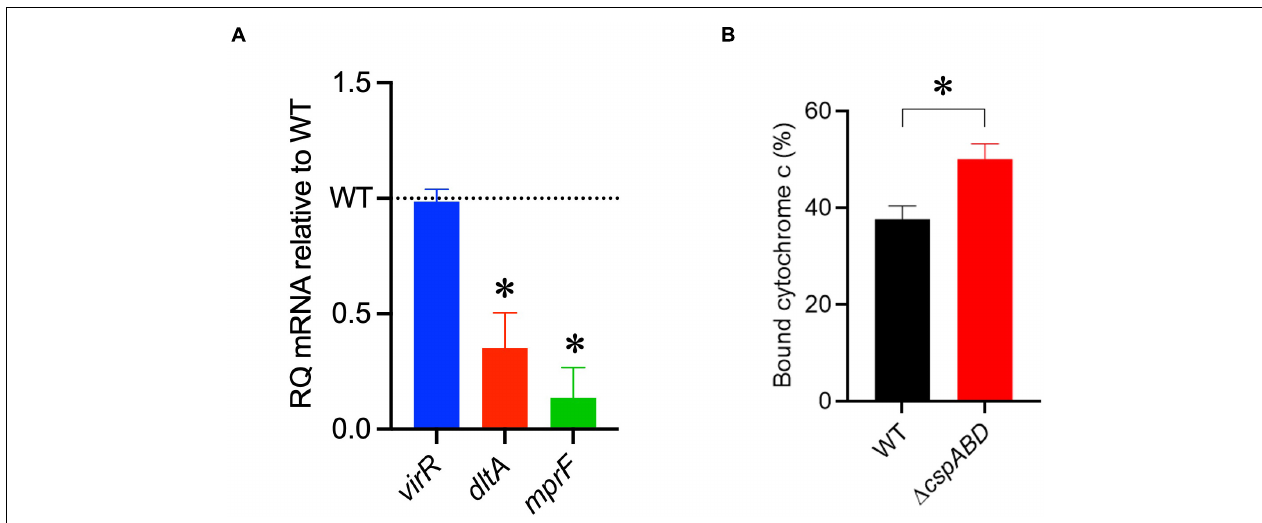
FIGURE 6 | A (cid:49) cspABD mutation reduces the mRNA abundance of nisin response genes and cell surface anionic charge. (A) virR , dltA , and mprF mRNA levels in L. monocytogenes EGDe_ (cid:49) cspABD are expressed relative to the wild type (WT) strain (WT level is 1.0 and is denoted by a dotted line). RT-qPCR was performed on mRNA isolated from exponentially growing cells cultivated in nisin (1.5 ppm)-supplemented BHI broth. 16S rRNA was used for mRNA normalization. (B) Bar graph showing the cytochrome C binding level of exponentially growing EGDe_ (cid:49) cspABD and WT cells cultivated until OD 600 1.0 in BHI at 37 ◦ C and 150 rpm. Cytochrome C binding expressed as a percentage was measured as the mean OD 530 values from replicate samples containing bacteria relative to the mean value of the sample supernatant lacking bacteria. ∗ P < 0.05, statistically significant differences between WT and (cid:49) cspABD mutant identified using the t -test for independent